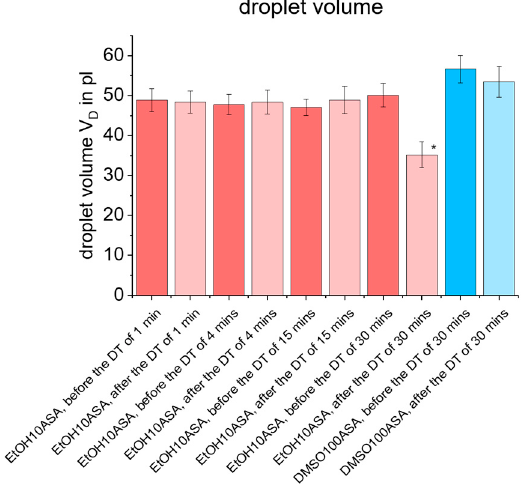
Figure 9. Plot of droplet volume V D for EtOH10ASA (c = 10 g/L ASA) and DMSO100ASA (c = 100 g/L ASA) before and after the dispensing tests (DT) with time periods t = 1 min, t = 4 min, t = 15 min and t = 30 min. In each time period, a number of 500 droplets was ejected uniformly. At a time period of t = 30 min, EtOH10ASA droplet formation is negatively affected by drug deposits on the printhead tip. The mean value decreases due to nozzle clogging caused by drug deposits (* the measurements were carried out at 2 out of 10 experimental replicates, termination of droplet formation occurred in 8 out of 10 experimental replicates). For DMSO100ASA, mean values and standard deviations did not change significantly. Droplet formation was not negatively affected, as there were no drug deposits on the printhead tip even at a time period of t = 30 min. The plot shows means ± standard deviations for n = 50.